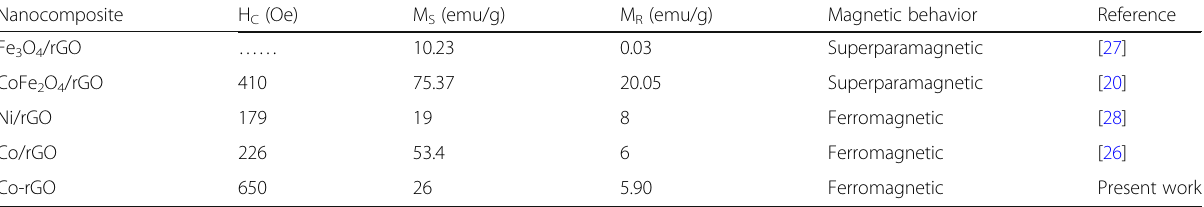
Table 2 Comparison of magnetic properties of present work with reported MNPs-rGO composite Nanocomposite